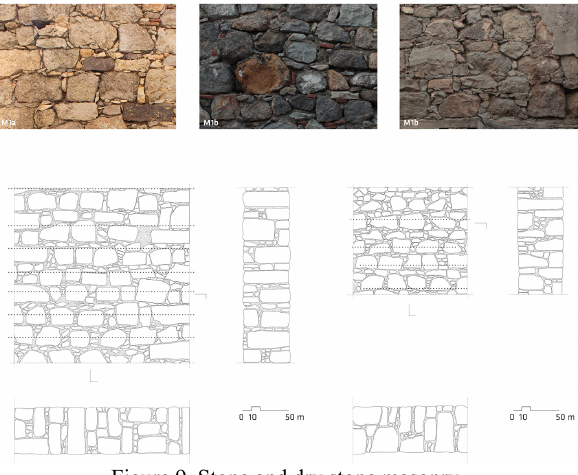
Figure 9. Stone and dry stone